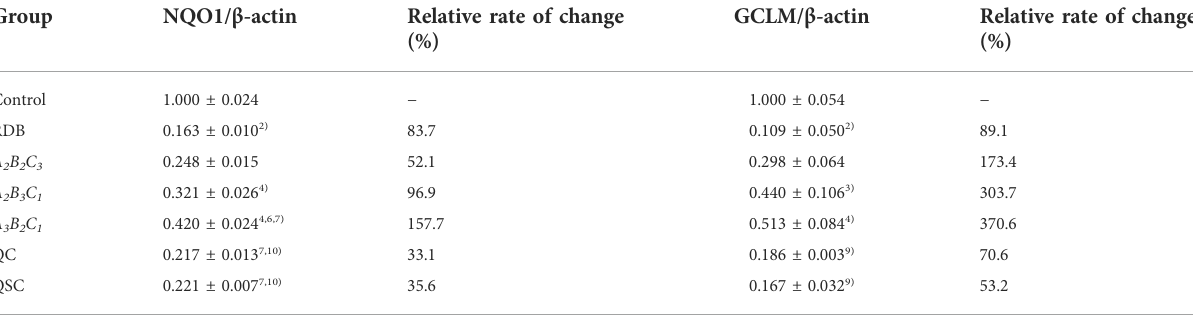
GCLM/ β -actin Relative rate of change (%) (%)